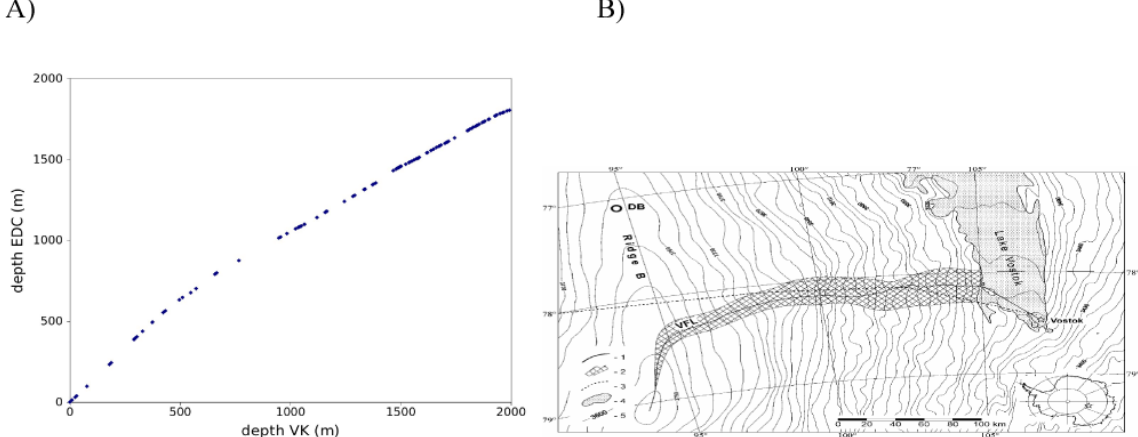
Fig. 7. (A) Volcanic tie points in a depth-VK/depth-EDC diagram. (B) The Vostok flow line (VFL) between Ridge B and Vostok, with the geographic situation of this Antarctic region in the lower right corner. Adapted from Salamatin et al. (2009a). The steep slope in graph (A) between 0 and 500m in VK corresponds to the lake part of the flow line, where the accumulation and bedrock elevation are lower than upstream.